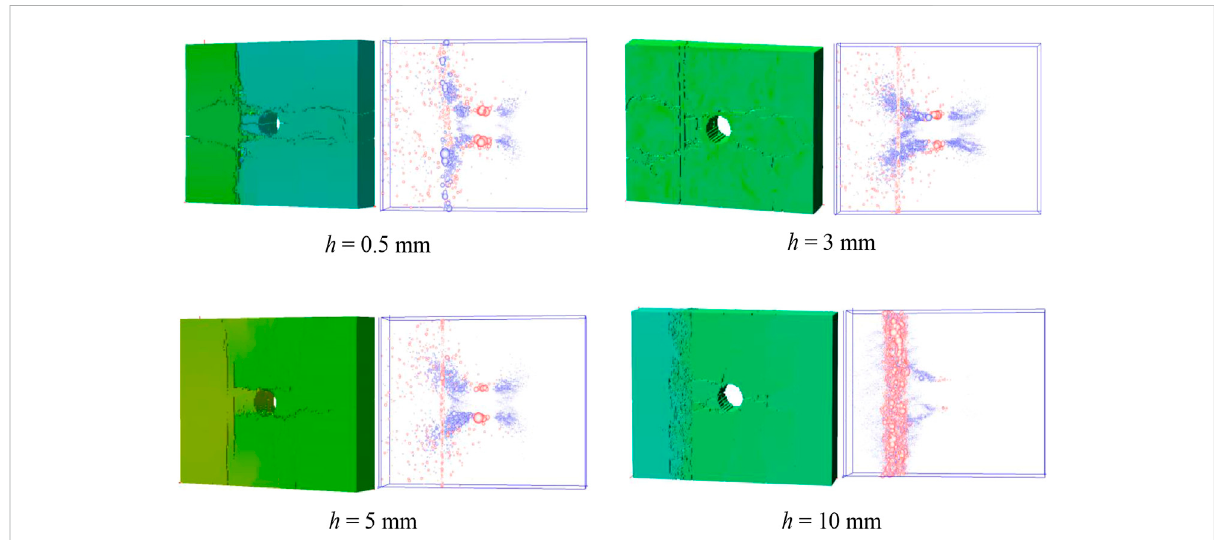
FIGURE 10 Failure patterns and AE distribution of jointed rocky with a pre-existing hole under different joint